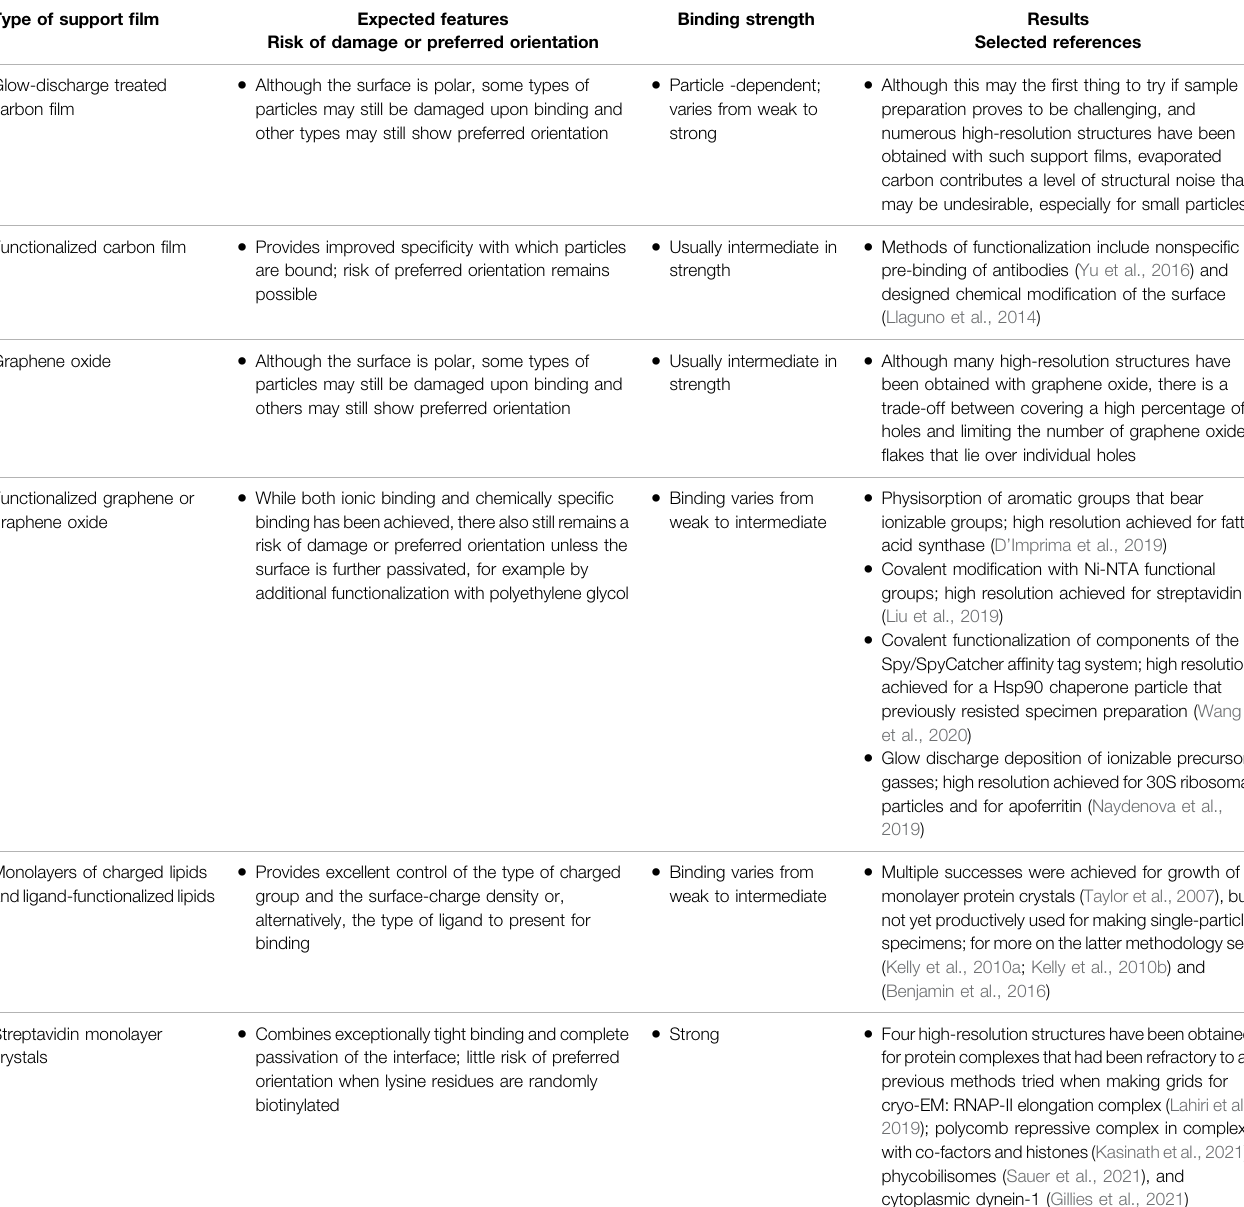
TABLE 1 | Representative examples of different types of af fi nity grids used for cryo-EM sample preparation, and the current status of results that have been